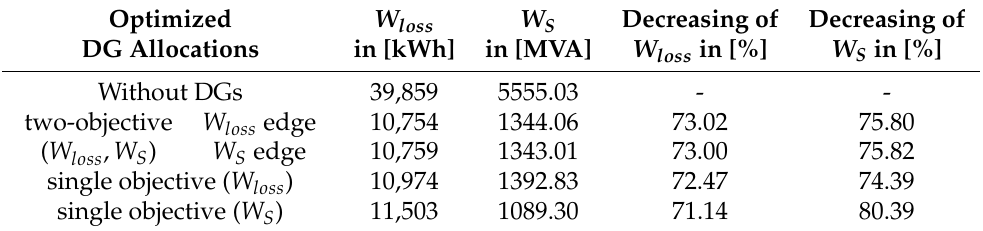
Table 6. Results for optimal solutions of Opt 3 optimization model for different objective functions (W1